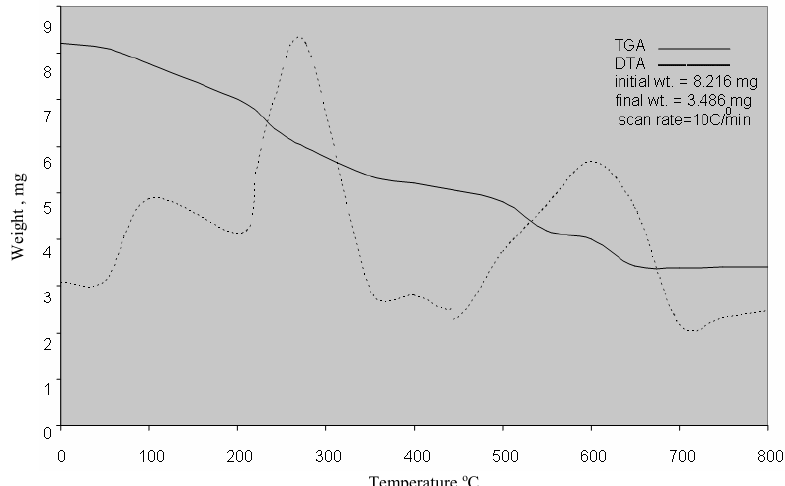
Figure 4. TGA/DTA Studies of [W(CO)